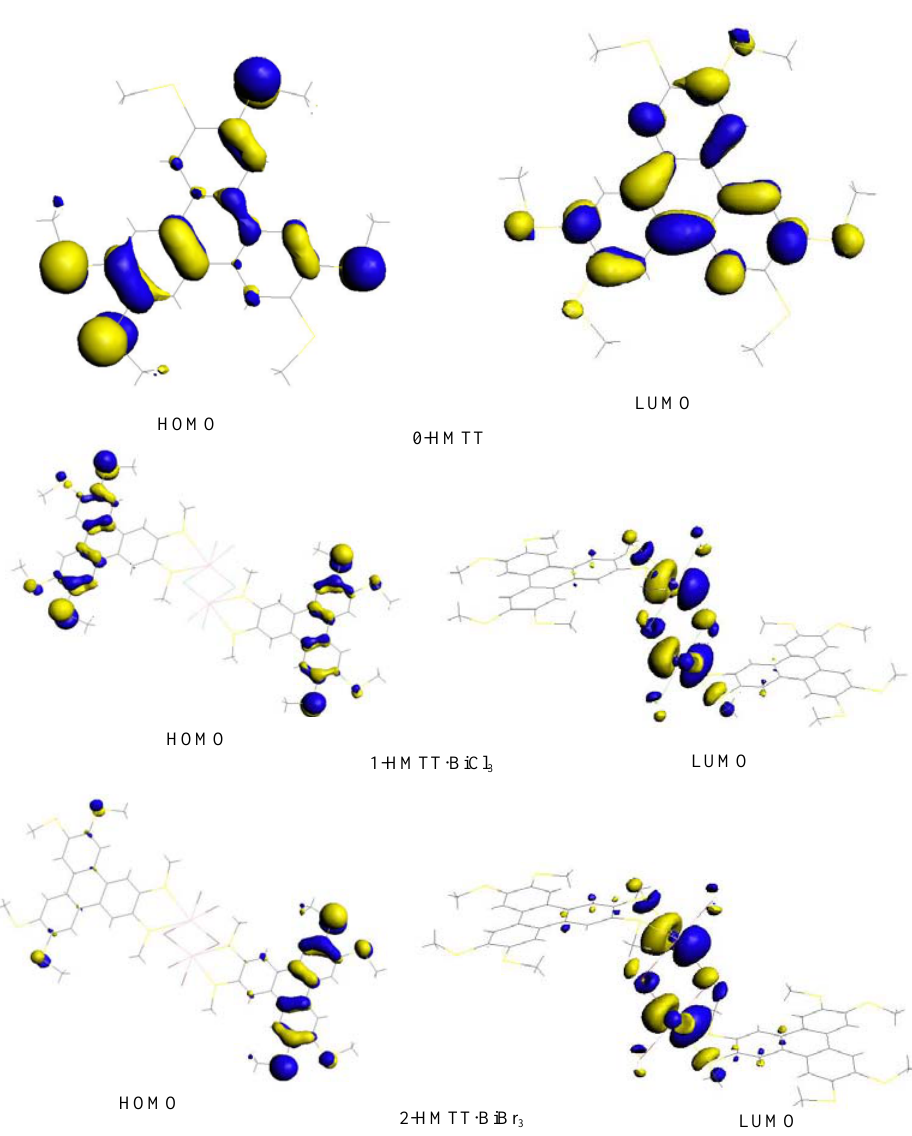
Figure 2 . Contour plots of the frontier molecular orbitals of compounds 0-HMTT, 1- HMTT·BiCl and 2-HMTT·BiBr 3